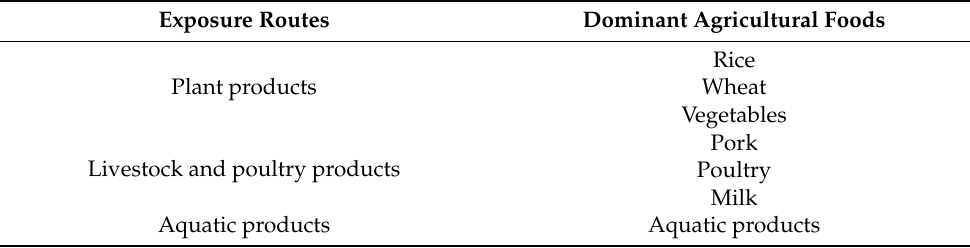
Table 1. Dominant exposure routes of agricultural